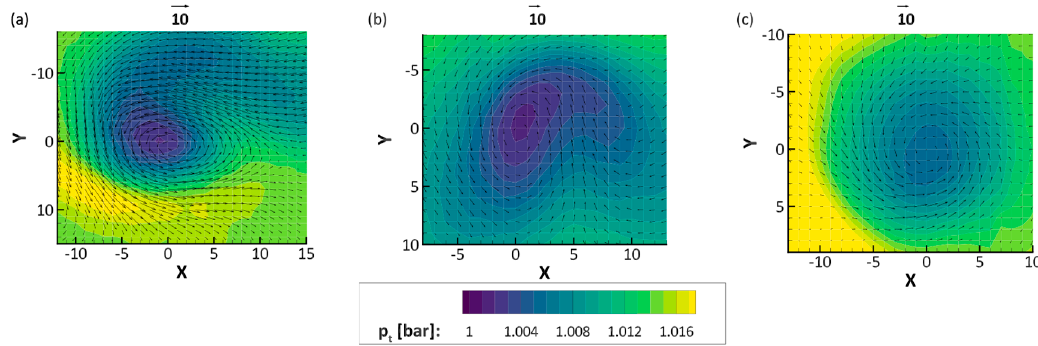
Figure 8. 5-hole probe p t results for: ( a ) type A, ( b ) type B and ( c ) type C swirlers; 1 bar is the static pressure, 1.016 bar is the mainstream total pressure.